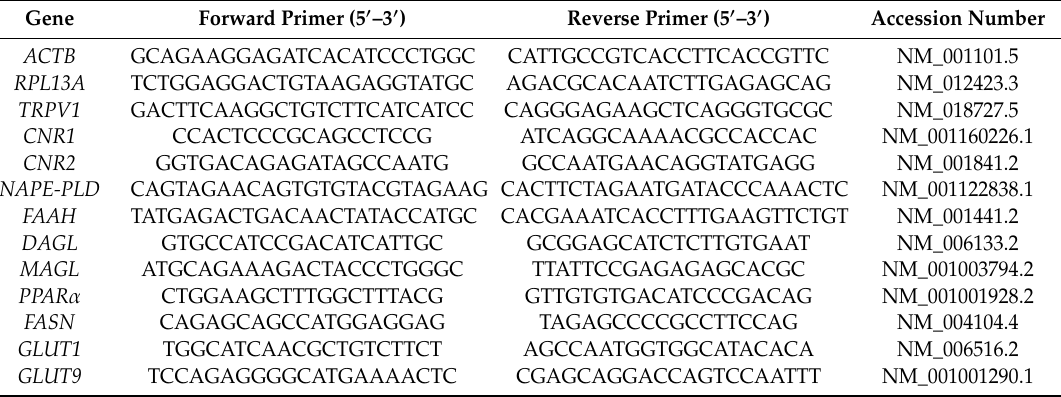
Table 2. List of primers used for gene expression analyses by Real-Time qPCR ( ACTB : actin beta; RPL13A : ribosomal protein L13a; TRPV1 : transient receptor potential cation channel subfamily V member 1; CNR1 : cannabinoid receptor 1; CNR2 : cannabinoid receptor 2; NAPE-PLD : N-acyl phosphatidylethanolamine phospholipase D; FAAH : fatty acid amide hydrolase; DAGL : diacylglycerol lipase; MAGL : monoglyceride lypase; PPAR α : peroxisome proliferator activated receptor alpha; FASN : fatty acid synthase; GLUT1 : glucose transporter 1 ( SLC2A1 : solute carrier